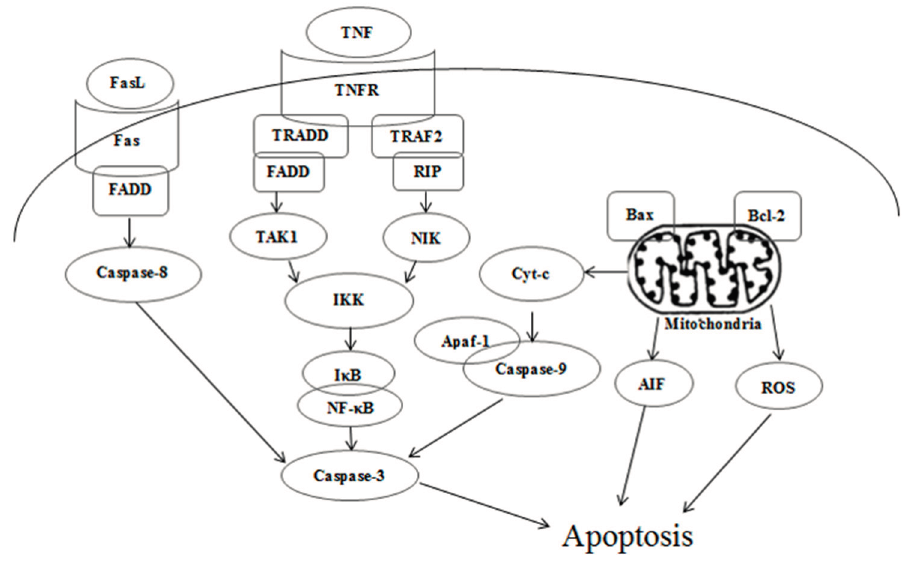
Figure 12. Death receptor and mitochondrial mediated apoptotic pathways induced by